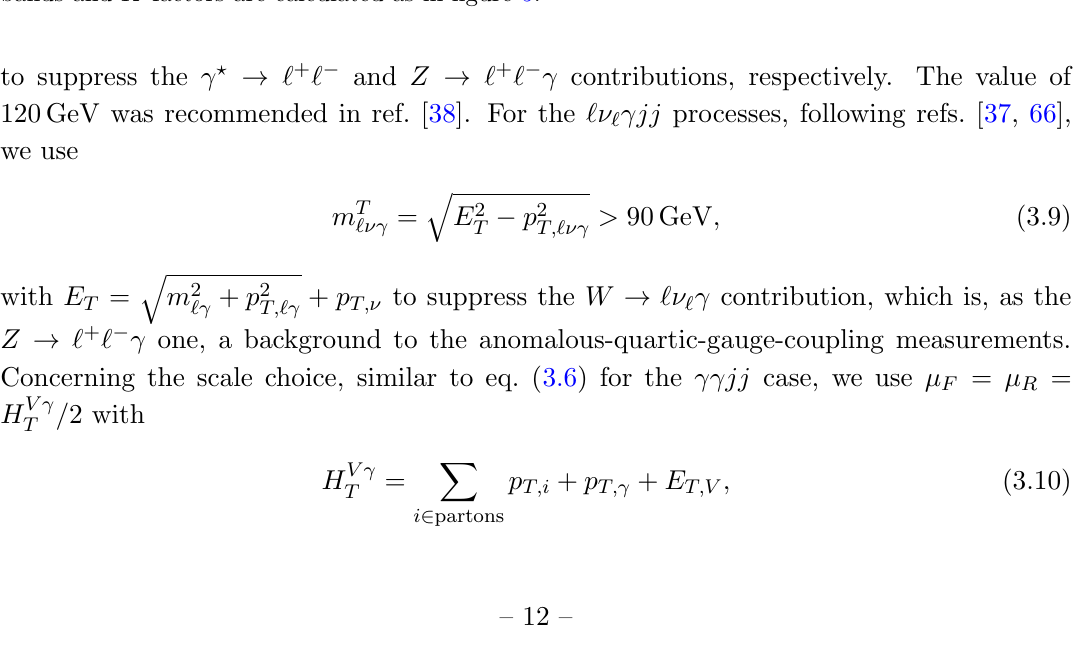
Figure 6 . Distributions of the absolute value of the rapidity separation between the two tagging jets (top left) and between the two photons (bottom left), of the azimuthal-angle separation between the two tagging jets (top right) and between the two photons (bottom right). The scale-uncertainty bands and K -factors are calculated as in (cid:12)gure